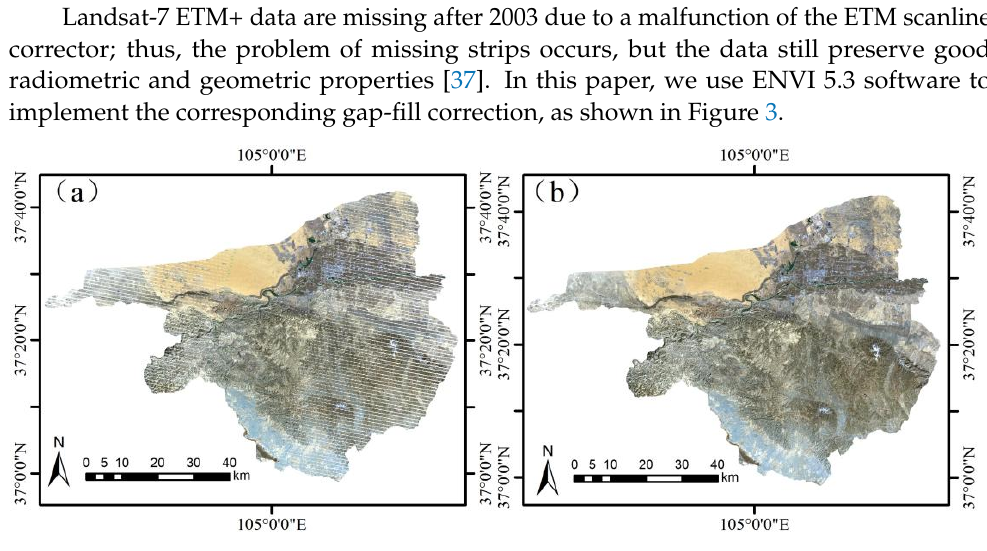
Figure 3. Repair of missing strip problems: ( a ) before restoration, ( b ) after the repair was completed, the data shown are Landsat -7 ETM+ and were collected on 2019/03/03.